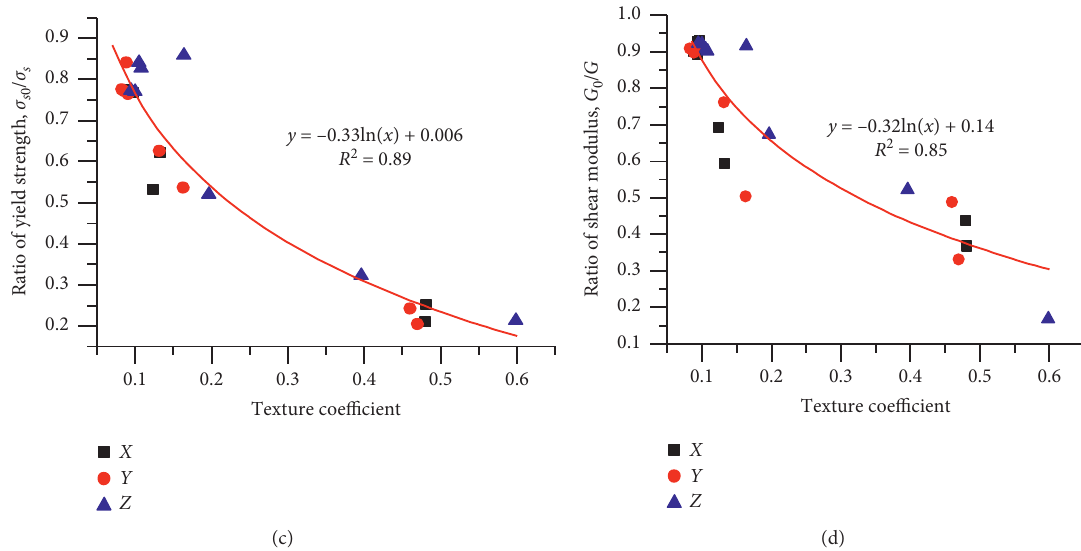
Figure 14: Correlation analysis between TC and digital core mechanical parameters. (a) ∼ (d) are the ratio of Young’s modulus, ratio of compressive strength, ratio of yield strength, and ratio of shear modulus against the model TC for correlation analysis.